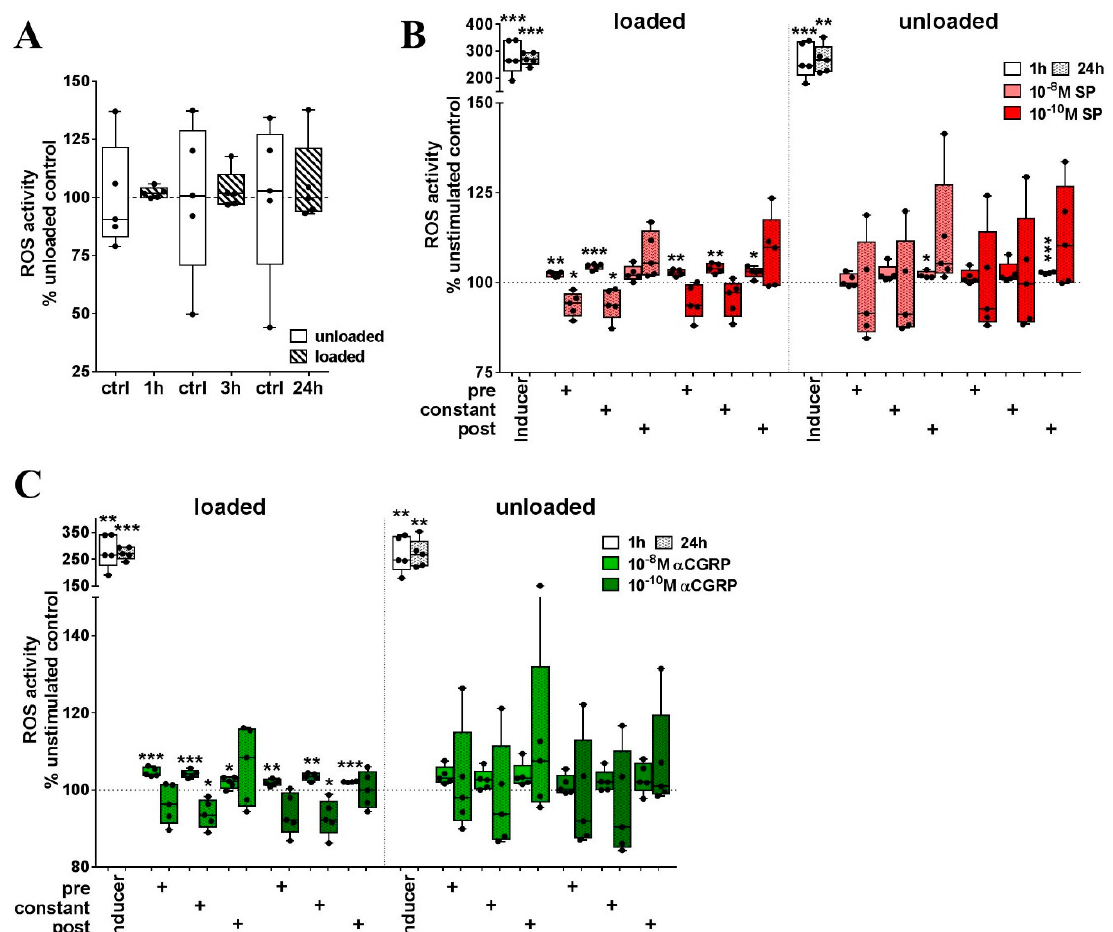
Figure 5. The impact of mechanical loading and sensory neuropeptide stimulation on the production of ROS in RAW264.7 cells. ( A ) ROS activity of loaded cells compared to unloaded cells (=100%) 1, 3 and 24 h after loading; ( B , C ) Effect of SP ( B ) and α CGRP ( C ) stimulation on ROS production of loaded and unloaded RAW264.7 in relation to the respective unstimulated cells (=100%) after 1 and 24 h. The graph depicts the effect of stimulation during loading ( pre ), during loading and assay ( constant ) and only during assay procedure ( post ). Effective ROS induction was verified using an inducer that was included in the assay kit (positive control). n = 5. One sample t -test * p < 0.05; ** p < 0.01; *** p < 0.001. ROS—reactive oxygen species, SP—substance P, α CGRP—alpha ‐ calcitonin gene ‐ related peptide.